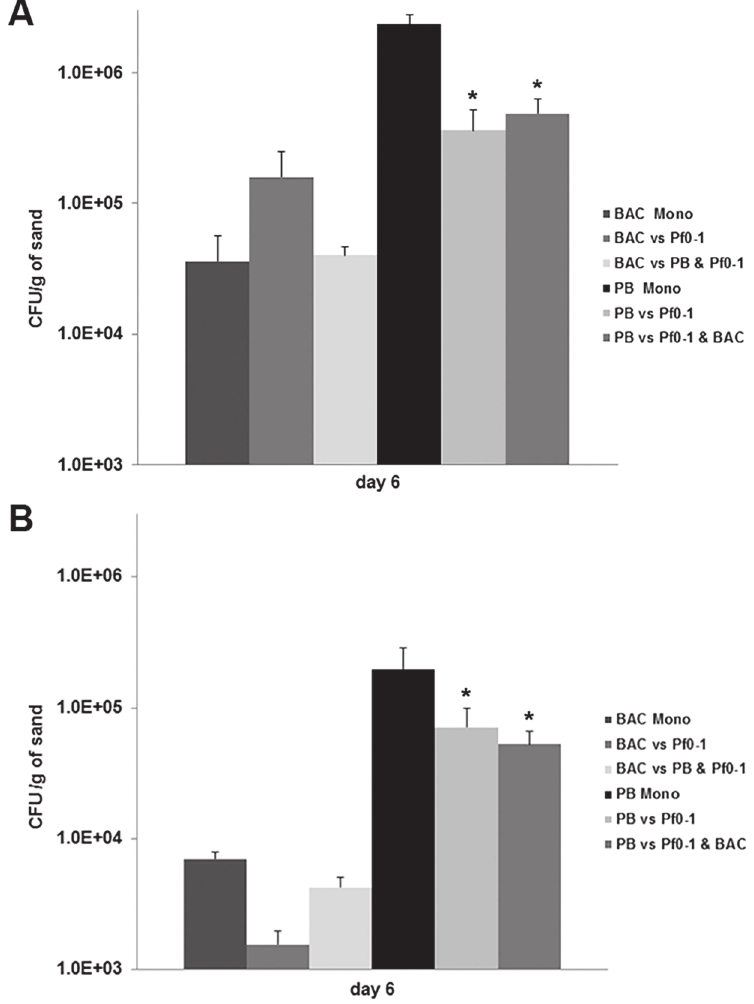
Fig 2. Numbers of CFUs of Bacillus sp. V102 and Pedobacter sp. V48 in monoculture and in mixed cultures (with strain Pf0-1) at day 6 under nutrient rich conditions (A) and under nutrient poor conditions (B). Significant differences between the CFUs in monoculture and in mixed cultures are indicated with an asterisk (p (cid:3) 0.05). Error bars are indicating standard deviation (SD) between the